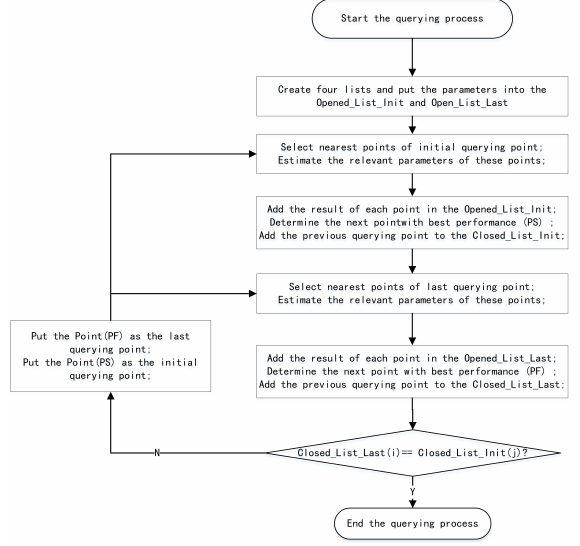
Figure 18. The querying process of the optimized PRM